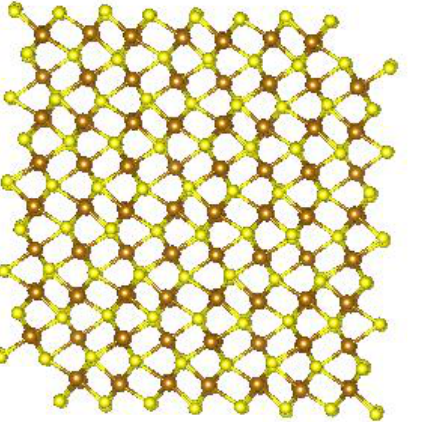
5 of 29 Figure 2. Break-down of the layered TMS structure into the basal planes, rim sites, and edge sites, and the HDS reaction associated with the rim and edge sites. The activities on the rim and edges sites translate to the layered TMS, which in turn translate into the CO 2 reduction reactions. For the MoS 2 -, TiS 2 -, and WS 2 -based electrocat- alysts, the edge sites are far more reactive than the basal planes. However, there has been